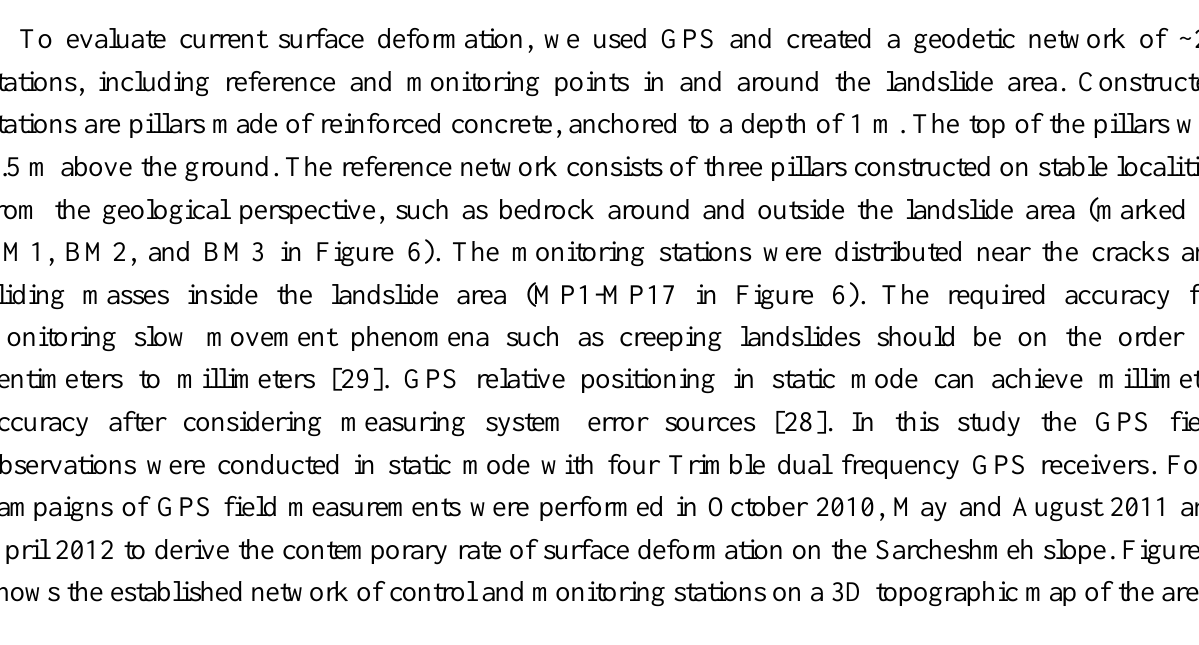
Figure 6. The spatial distribution of Global Positioning System (GPS) stations used in this study, overlaid on a 3D view of the topography map with 1 m contour